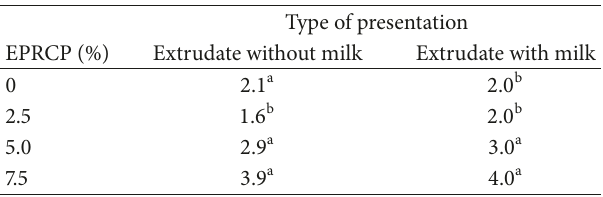
Table 5: Preference ∗ of extrudate cereal pigmented used encapsu- lated powder of red cactus pear (EPRCP) as